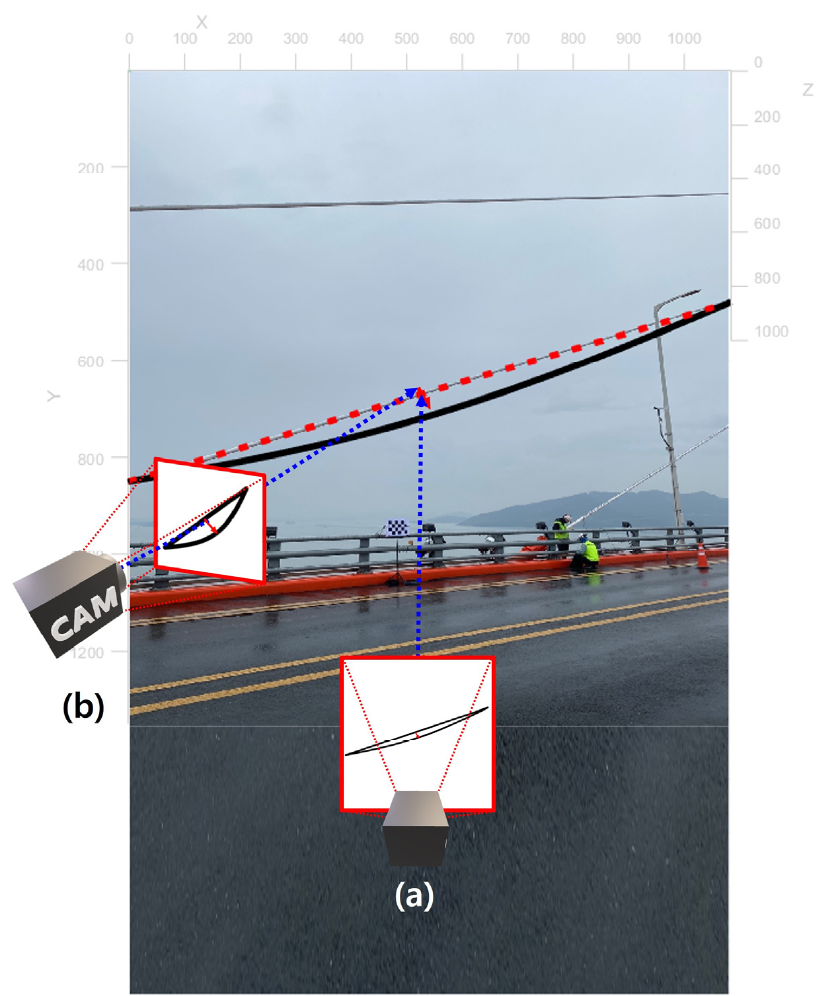
Figure 1. Camera locations for measuring cable displacement ( a ) front view and ( b ) side